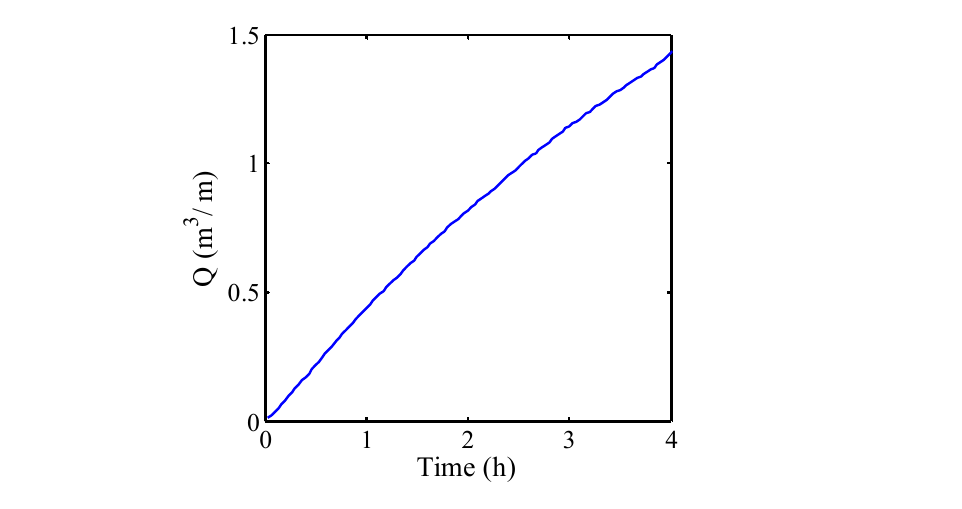
Figure 8. Time history of the accumulative volume of overtopping water recorded in Test 3.